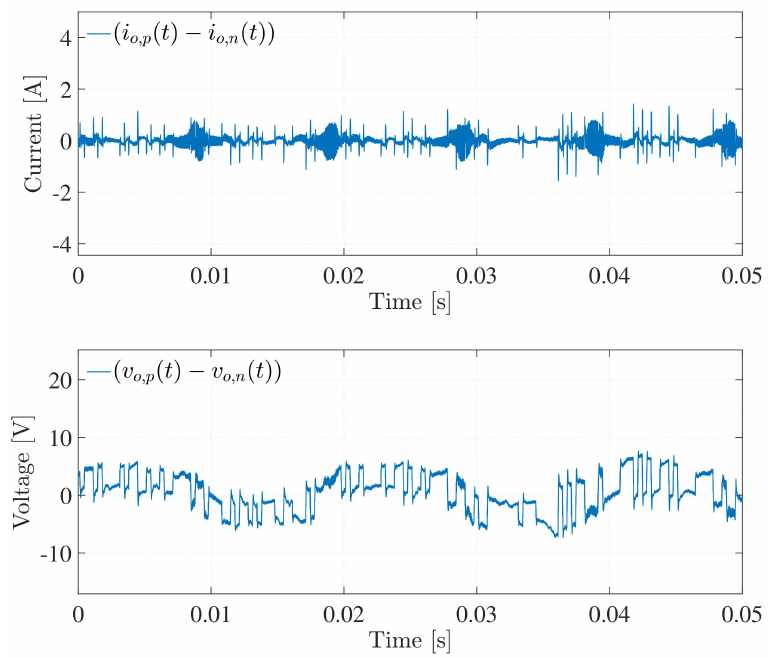
Figure 19. Small-signal perturbations of the current, ( i o , p ( t ) − i o , n ( t ) ), and the voltage, ( v o , p ( t ) − v o , n ( t ) ), after PRBS